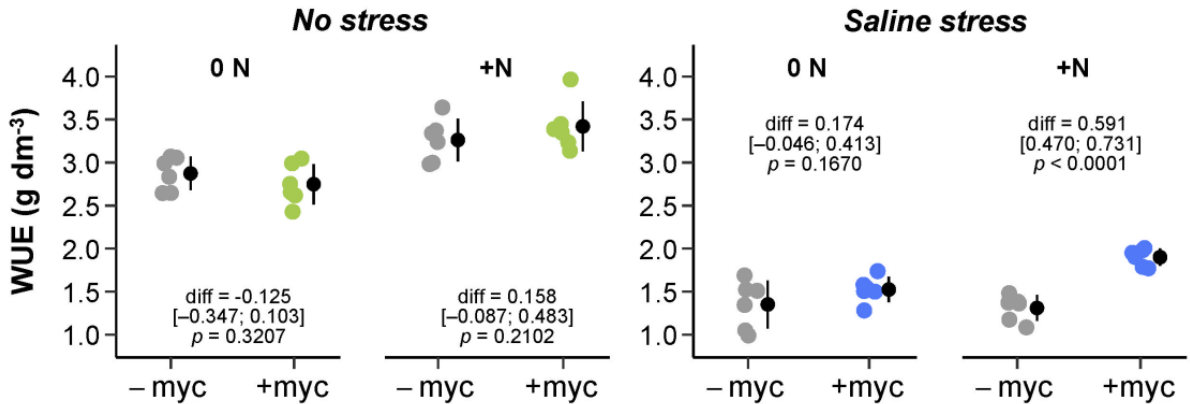
Figure 7. Water use efficiency (WUE; g DW per dm 3 H 2 O utilized) of durum wheat to varying treatments: no-stress or saline stress condition; N fertilization treatments (0 N, +N); absence or presence of arbuscular mycorrhizal fungal inoculum ( − myc, +myc). Black circles represent means, with whiskers representing ± SE ( n = 6). Differences between +myc and − myc means within the same fertilization treatment and the same saline treatment, estimated 95% confidence intervals of mean difference (in brackets), and p values are reported inside the plots.